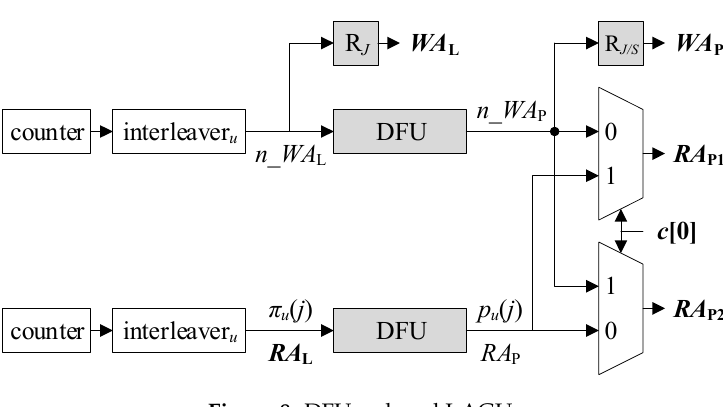
Figure 8. DFU-reduced I-AGU.